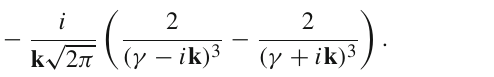
in Fig. 1b, where a comparison of Debye masses with and without incorporating the quarks masses is